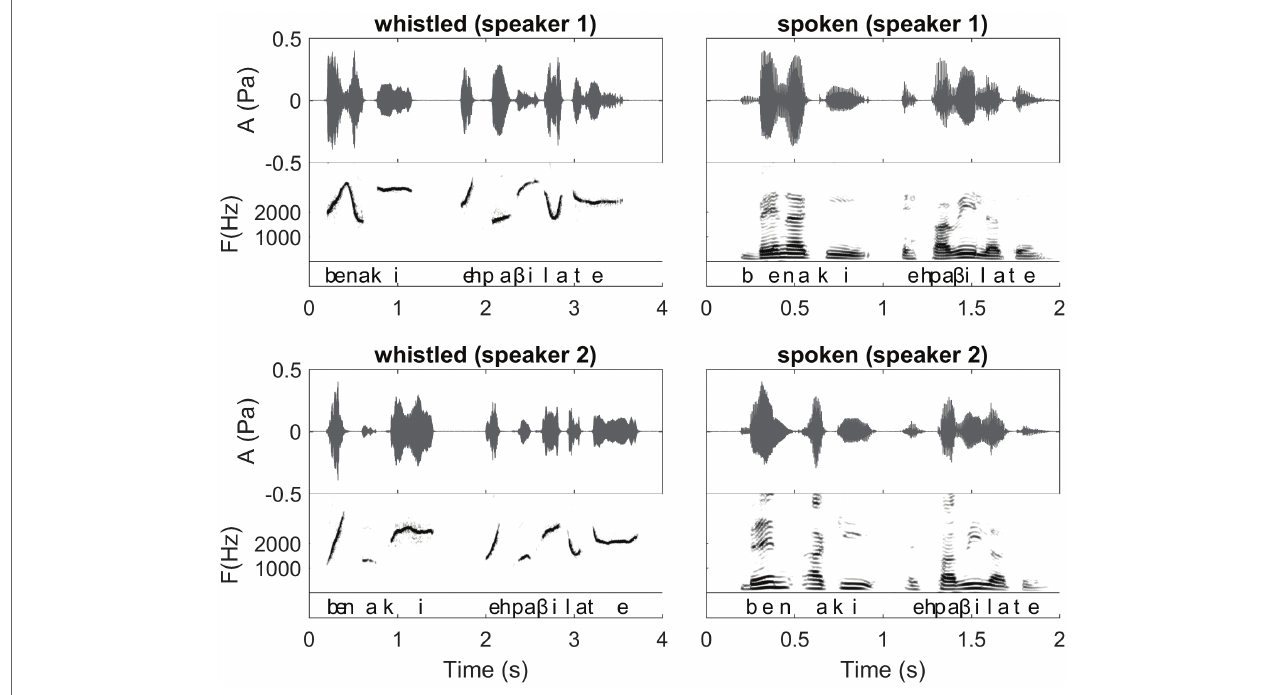
FIGURE 2 | Waveforms and Spectrograms of the Spanish sentence “ven aqui espavilate” expressed both in spoken and whistled forms by two different speakers (presented in phonetic transcription in the figure and meaning “come here, hurry up”). In this figure, we can follow the dynamics of the sentence in both modalities. It illustrates the spectrographic differences/similarities between spoken and whistled modalities that are explained in “General description of dolphin and human whistled communication systems” of the paper. There is also a difference between speakers in the segmentation of the two first syllables corresponding to the boundary between the two first words “ven” and “aqui.” Interestingly, this difference happens in both spoken and whistled modalities showing that the speakers were consistent in their pronunciation across modalities. The first speaker says /bena/ (/n/ is continuous between /e/ and /a/), whereas the second speaker says / ben.a/ with a clear pause between /en/ and /a/. Both forms are acceptable for a Spanish listener. Other aspects that this figure illustrates also: 1) different whistlers whistle at different general frequency levels. 2) Vowels are distributed at different frequency levels and consonants represent modulations in frequency and amplitude of the more steady frequencies of the vowels. (Recordings and edition by Julien Meyer, listen to sound extracts in Meyer and Diaz, 2021).